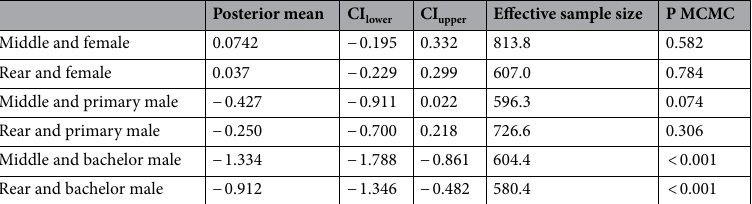
Table 5. Effect of being a female, a primary male, or a bachelor male on the likelihood for an individual to take front, middle or rear positions during a group progression. Reference categories are the front third or each sex/reproductive status category. Posterior means, confidence intervals, sample size, and P-values derived from MCMC